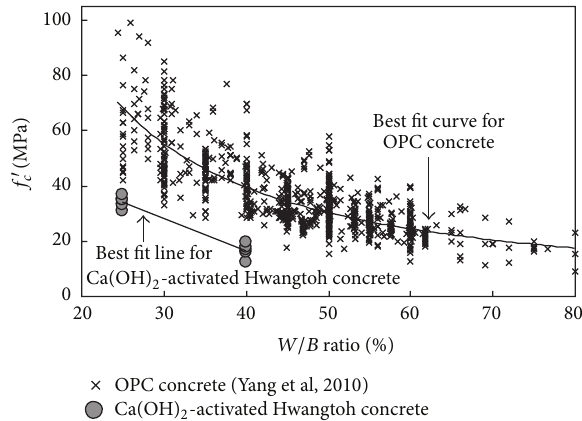
Figure 3: Effect of the water-to-binder ratio ( 𝑊/𝐵 ) on compressive strength ( 𝑓 󸀠 𝑐